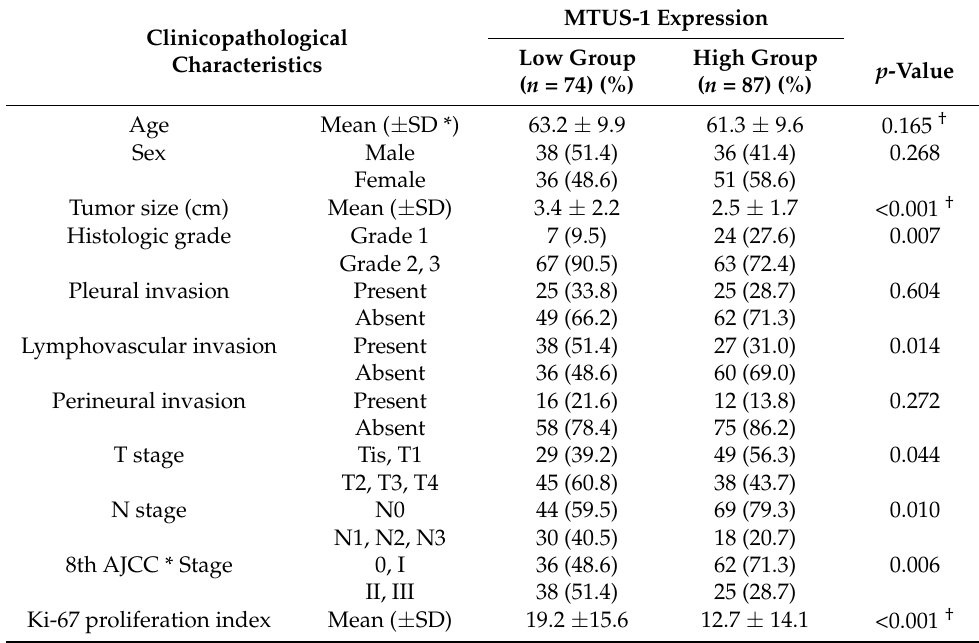
Table 2. Correlation between microtubule-associated tumor suppressor 1 (MTUS1) expression and clinicopathological factors in lung adenocarcinoma ( n =